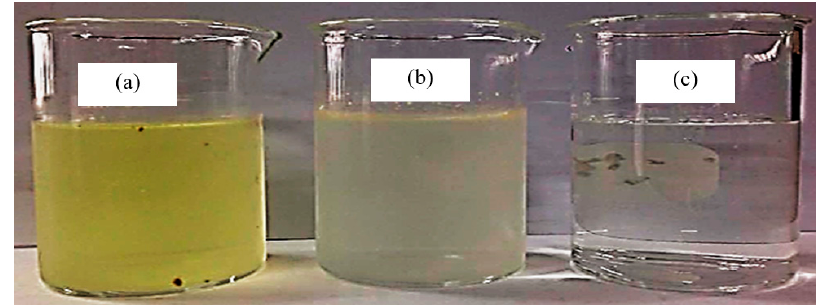
Figure 2. Appearance of ( a ) fresh wastewater; ( b ) acid-pretreated wastewater and ( c ) treated wastewater by photocatalytic oxidation.